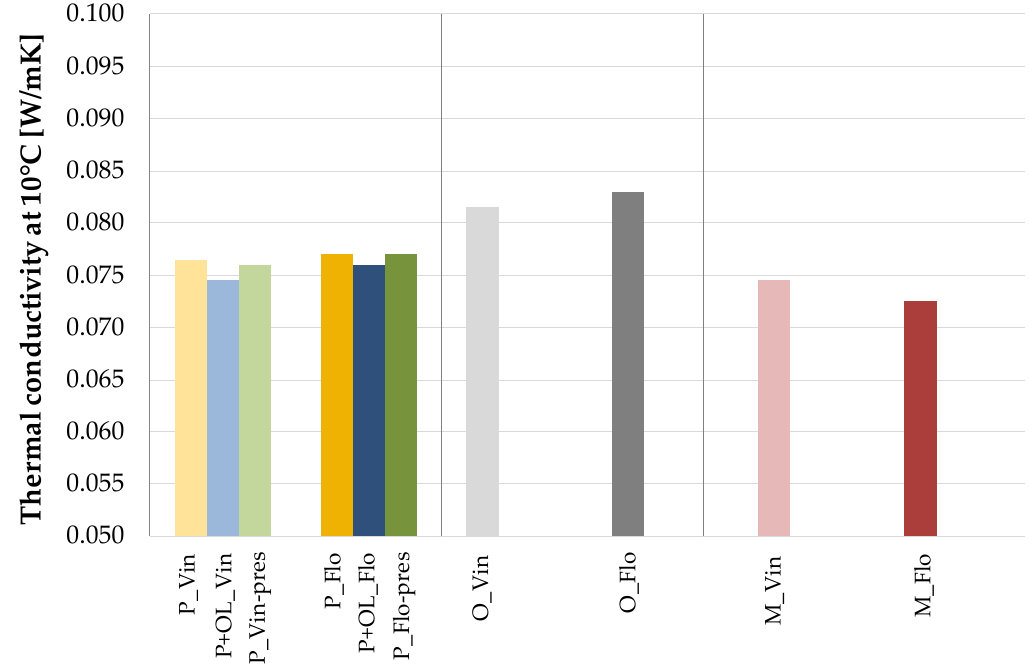
Figure 4. Thermal conductivity of the panels reported at 10 °C, according to ISO 10456 [39]: influence of different species and assembling techniques.